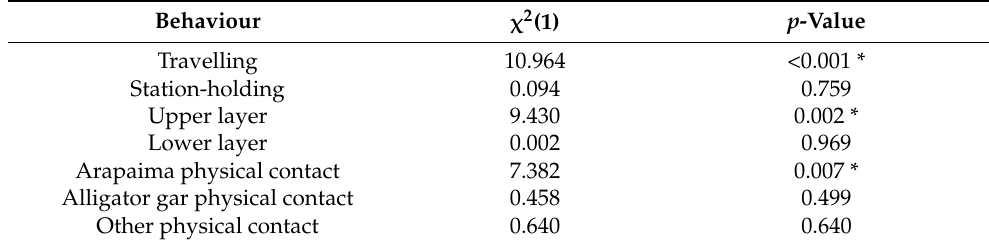
Table 4. Results of relative duration (time spent with each behaviour divided by the time the individual spent in the exhibition tank) likelihood ratio test (df = 1) comparing the two linear mixed models, one with and the other without the fixed effect (effect of the use of the green laser